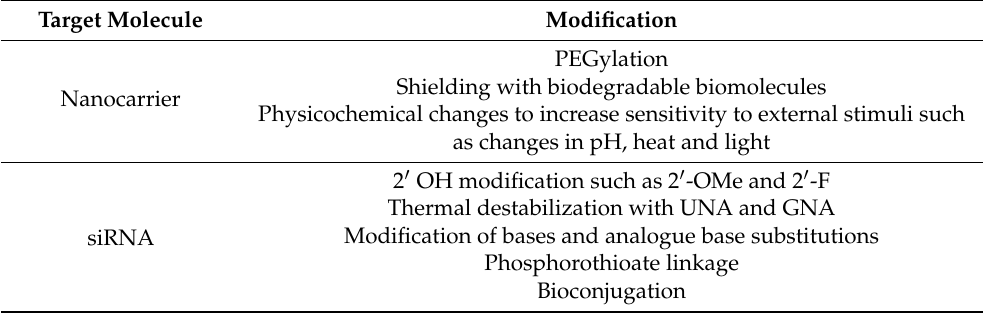
Table 4. Examples of chemical modification of nanocarriers and